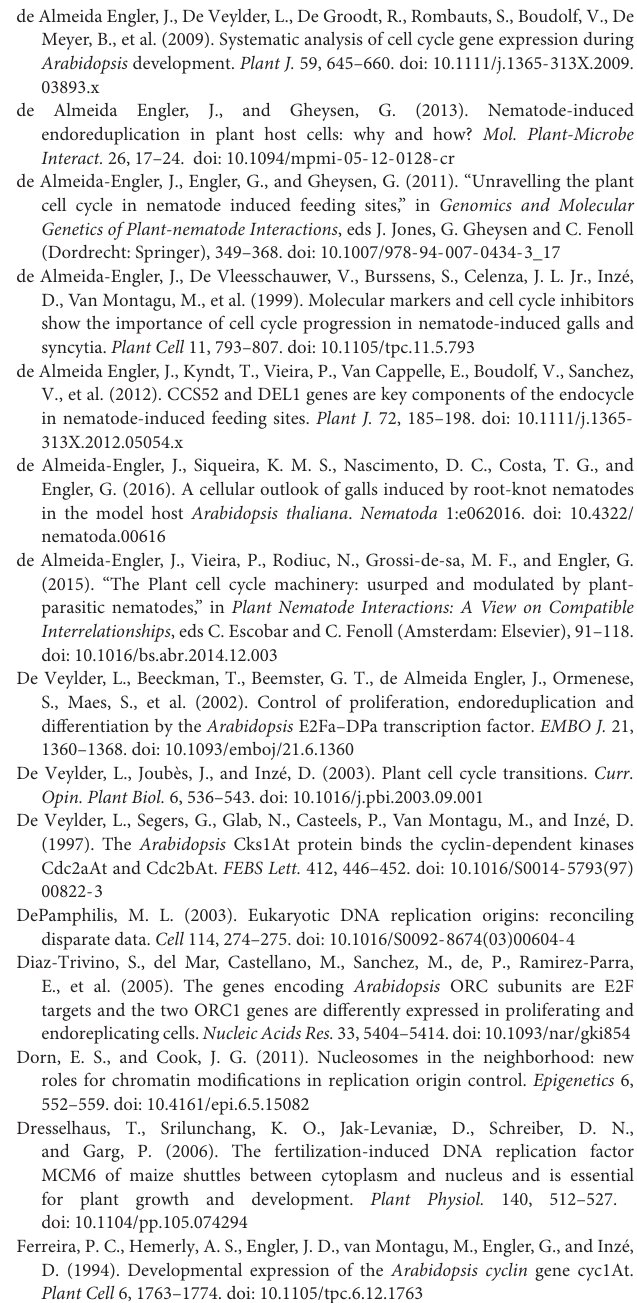
Supplementary Figure 1 | Spatial localization of CDT1a and CDT1b transcripts by non-radioactive in situ hybridization in Meloidogyne incognita- induced galls of Arabidopsis. Bright-field images of mRNA in situ hybridization in nematode feeding sites (orange dotted lines) 7 and 14 DAI. Sections were hybridized with DIG-labeled antisense (AS) probes. CDT1a and CDT1b hybridization signal is shown as purple color under bright-field optics. UR, uninfected root; DAI, days after inoculation; VT, vascular tissue; DAI, days after inoculation; n, nematodes. Bars = 50 µ m. Supplementary Table 1 | List of primer sequences used for qRT-PCRPCR